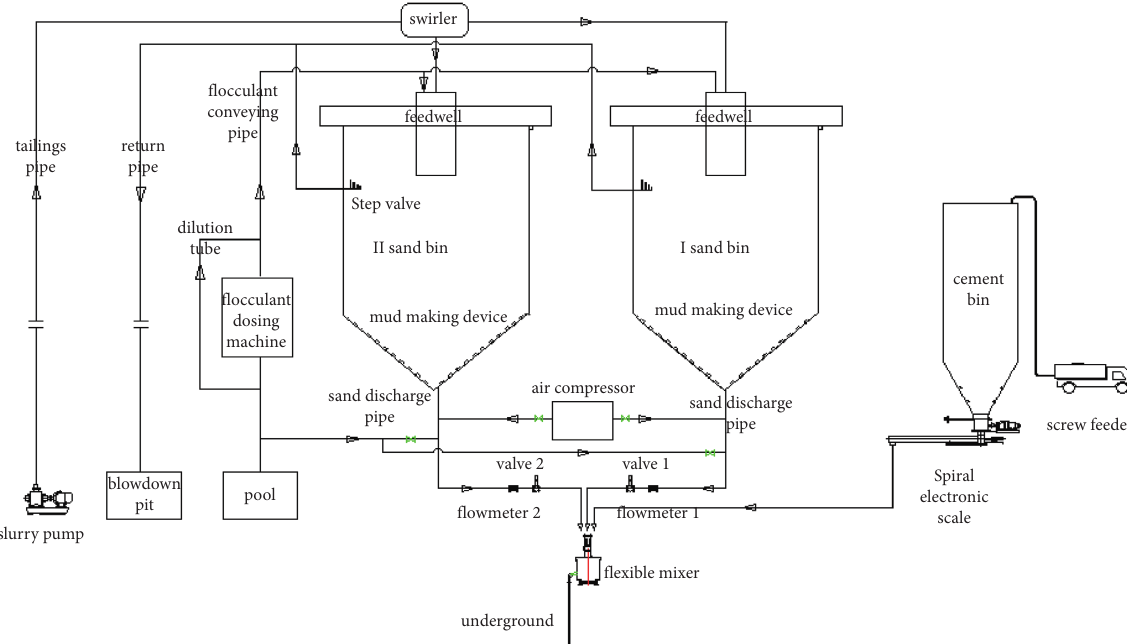
Figure 12: Technical process of the filling system for coarse and fine tailings’